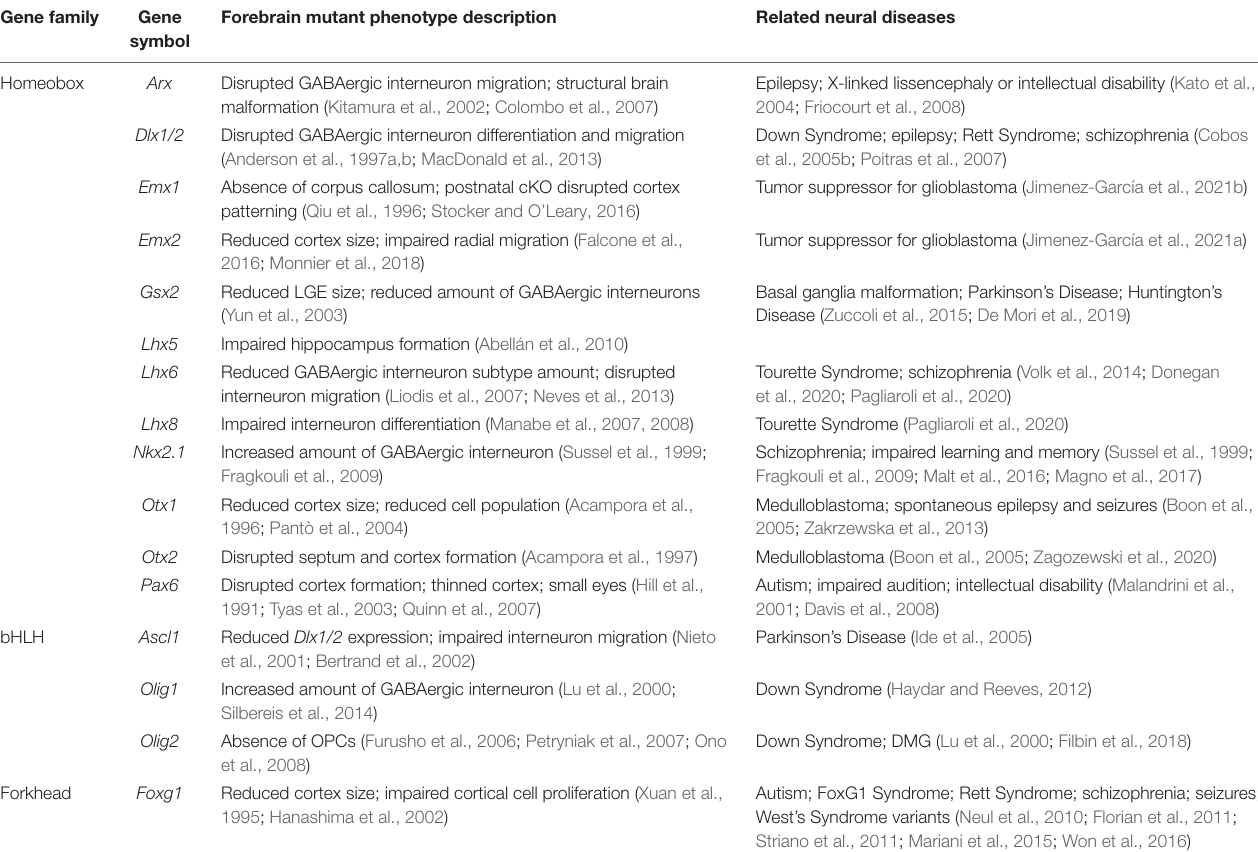
TABLE 3 | Forebrain mutant phenotypes and related